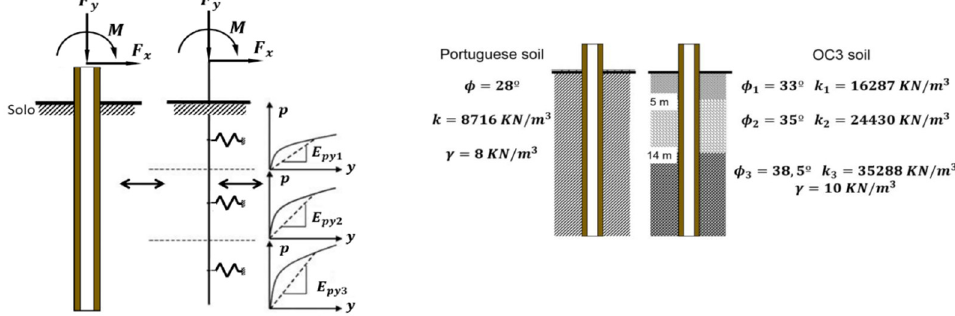
Figure 6. Representation of the p-y model, where each depth is described by a unique p-y curve (left); and properties of both the soils analyzed (right).